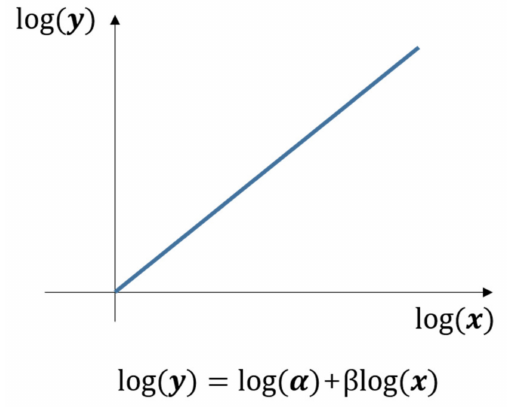
Figure 4. Linear regression analysis graph (log-transformed).